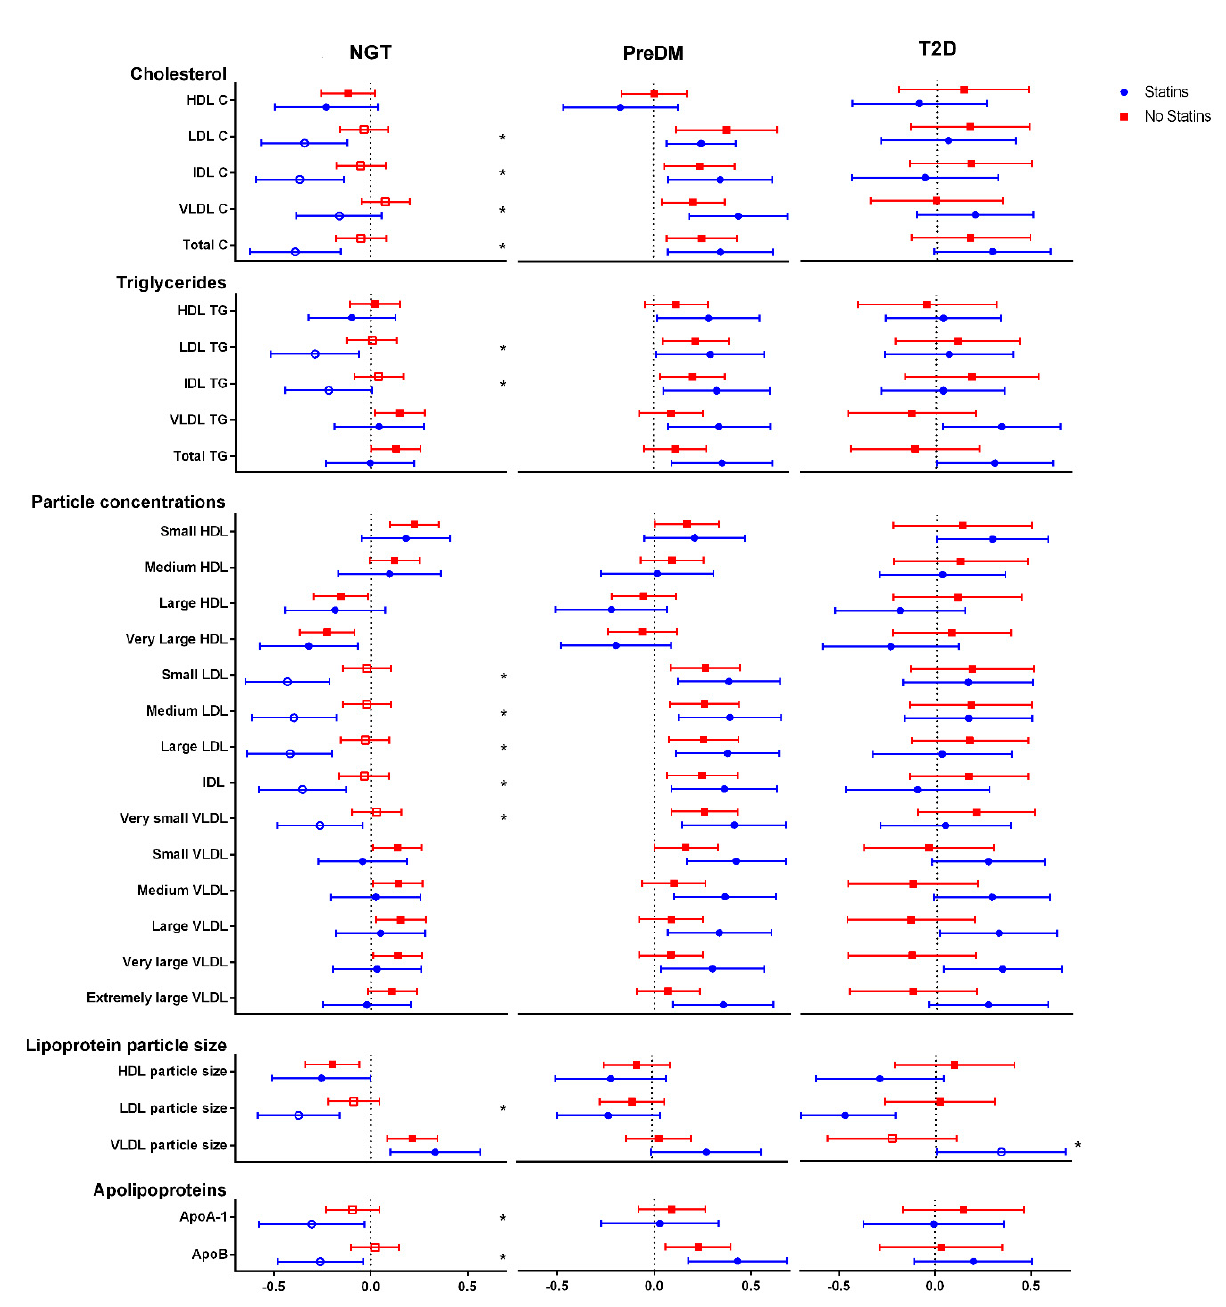
Figure 2. Associations between plasma NMR lipids and apolipoprotein metabolites, and Proprotein convertase subtil- isin/kexin type 9 (PCSK9) in normal glucose tolerance (NGT), prediabetes (PreDM) and type 2 diabetes (T2D) subjects. n = 608, regression coefficients shown, * ≤ 0.05. HDL, high-density lipoprotein; LDL, low-density lipoprotein; VLDL, very low-density lipoprotein; IDL, intermediate-density lipoprotein; C, cholesterol; TG, triglyceride; ApoA-1, Apolipoprotein A1; ApoB, Apolipoprotein B.